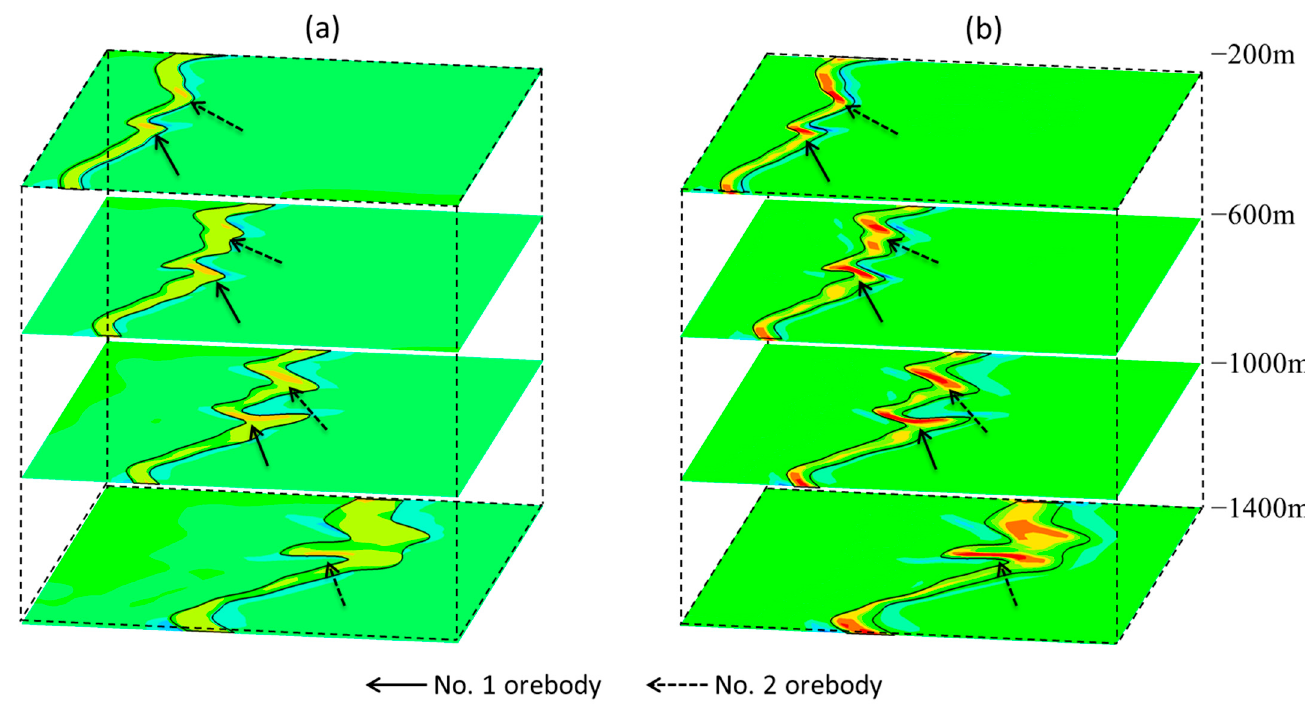
Figure 12. Spatial distribution of dilation deformation on horizontal planes. ( a ) after 0.5% and ( b ) 1% of bulk